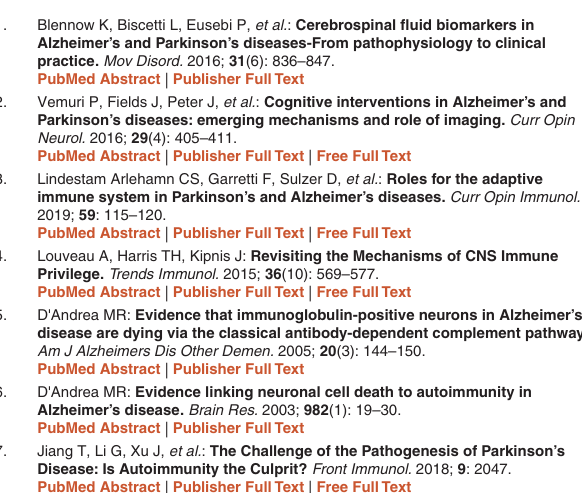
Supplementary Table 2 (Brain-specific self-antigens . and the number of associated peptides used to identify the protein in each sample. In the expanded spreadsheet, "I" indicates that the peptide was identified in the